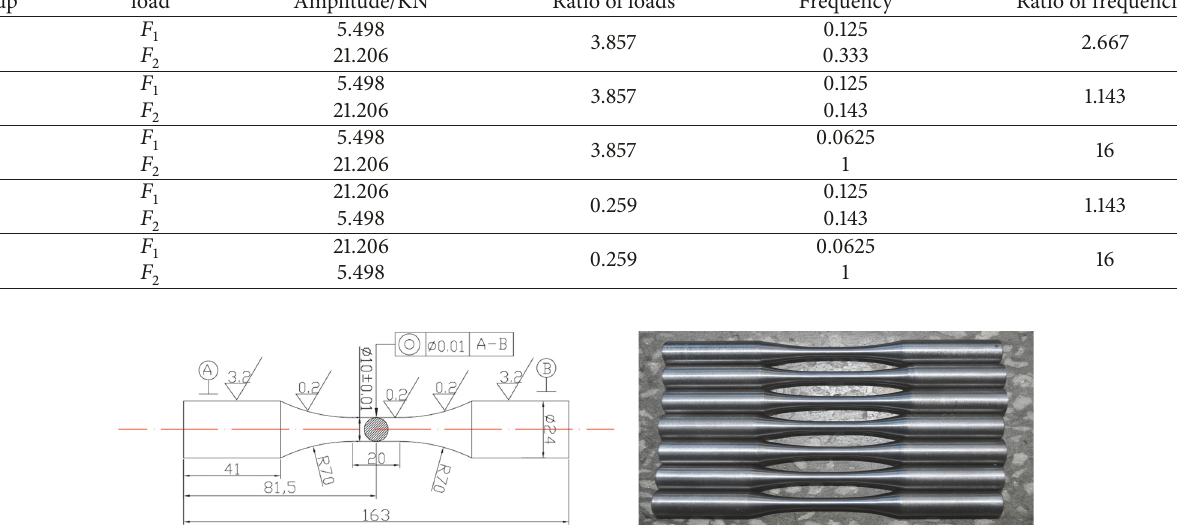
Figure 7: Designed specimens.